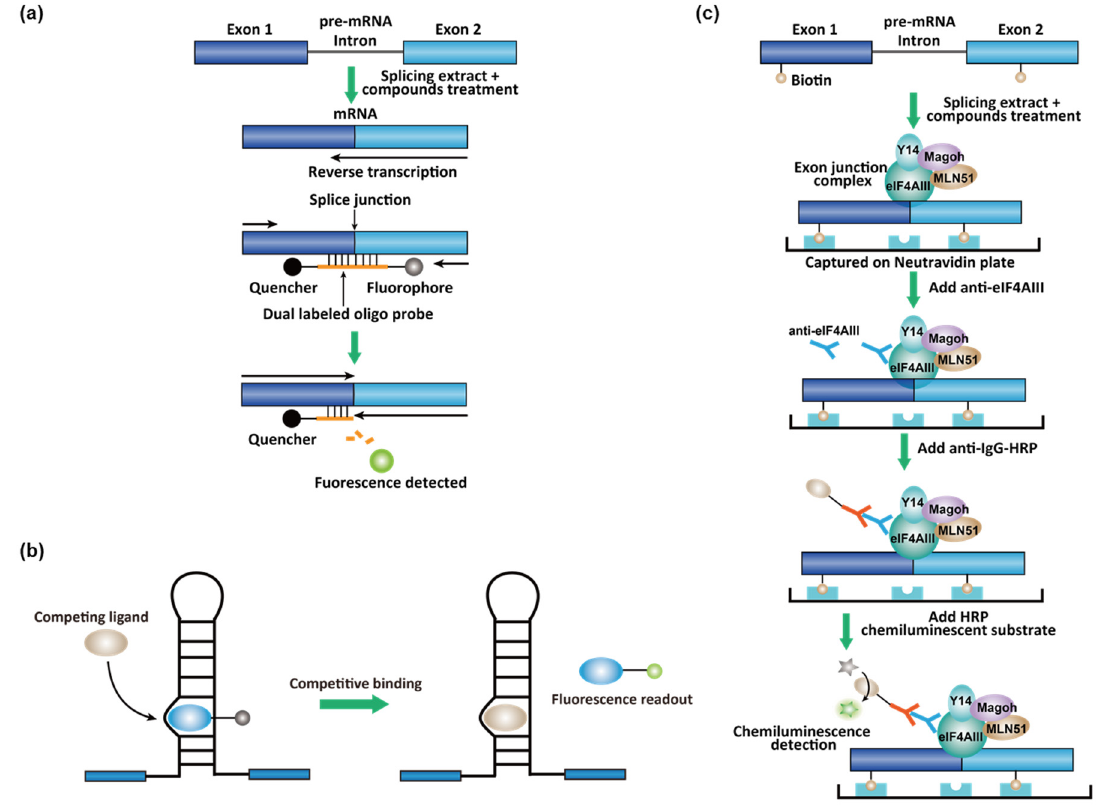
Figure 11. ( a ) RT-qPCR assay for the exon–exon junction sequence. ( b ) Fluorescent competition assay for MAPT exon 10 splicing. ( c ) Exon junction complex (EJC) detection assay (Copyright © 2021, American Society for Microbiology. All Rights Reserved [166]). HRP = horseradish peroxidase.